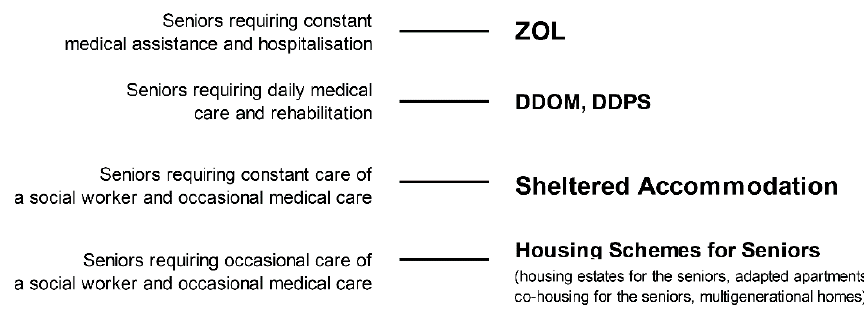
Figure 2. The organisational scheme of the eldercare system, depending on the health condition of the seniors. A. Skórka. the seniors. A. Sk ó